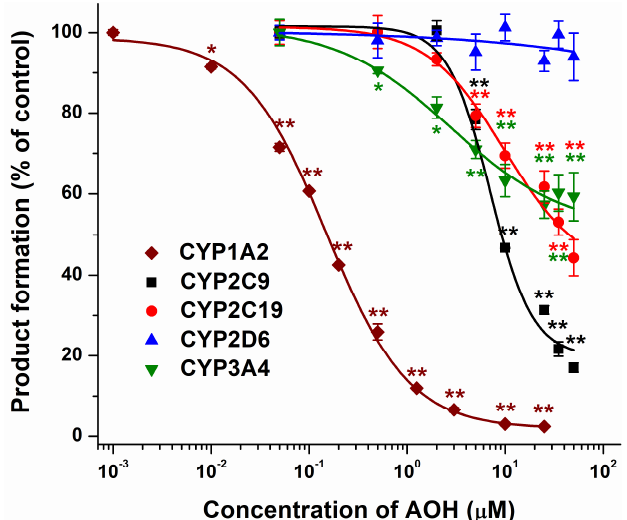
Figure 1. Concentration-dependent inhibitory effects of AOH (0–50 μM) on CYP1A2, CYP2C9, CYP2C19, CYP2D6, and CYP3A4 enzymes (n = 3; * p < 0.05, ** p < 0.01).